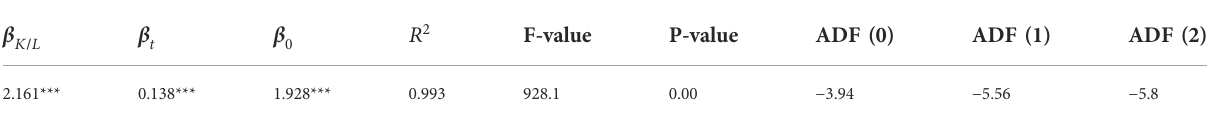
TABLE 1 Calculation results of related indicators in Eq. 8.